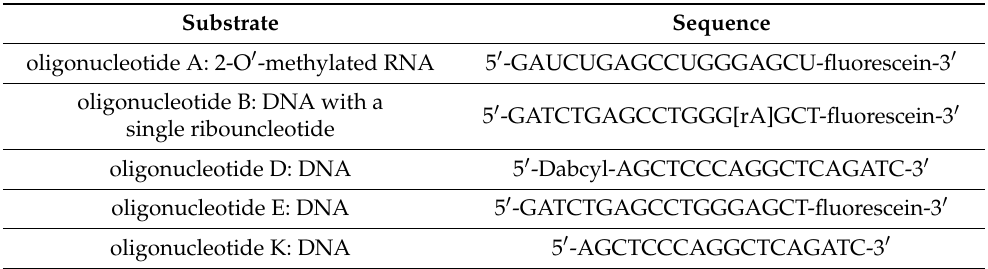
Table 2. RNase H2 assay substrates. Oligonucleotides A, B and E align to the anti-sense oligonu- cleotides D or